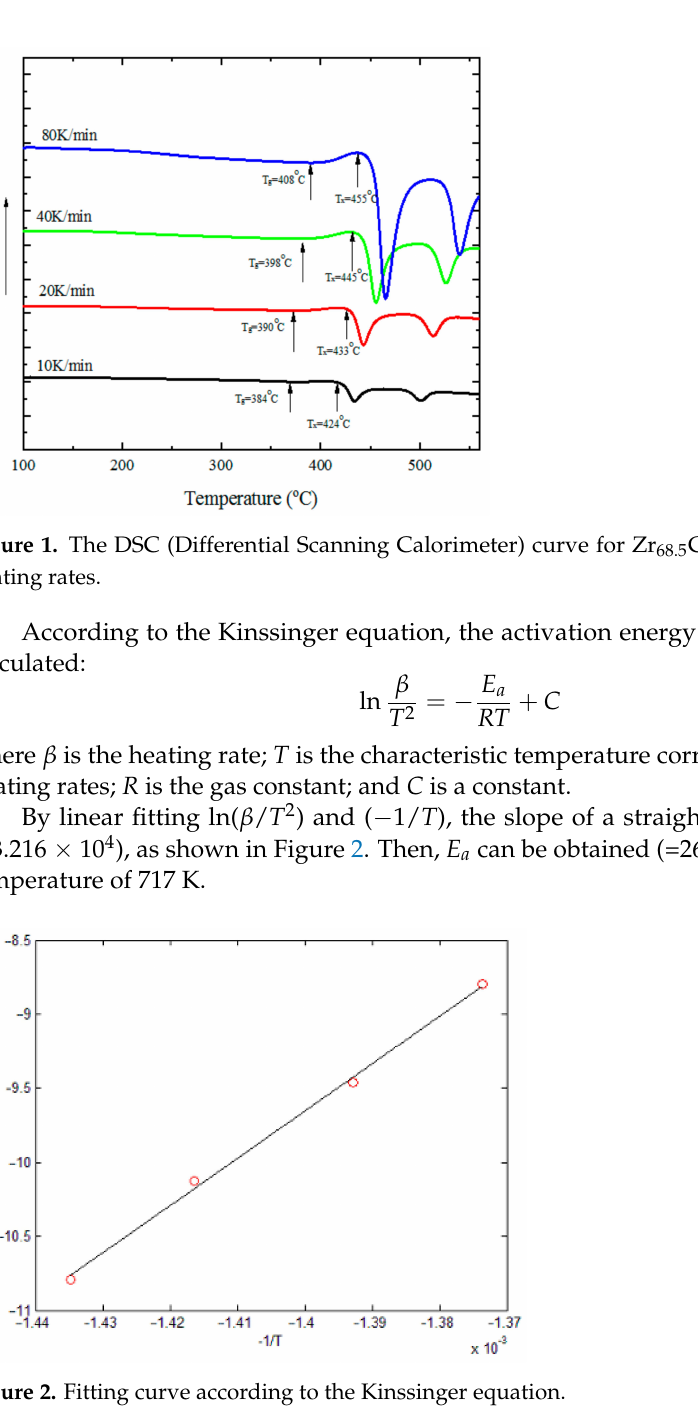
Figure 2. Fitting curve according to the Kinssinger equation.